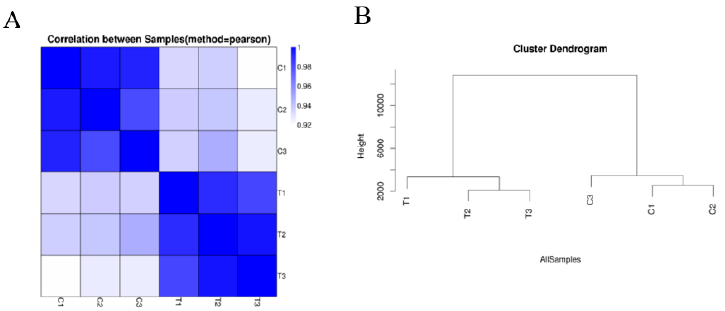
Figure 1. Sample quality test. ( A ) Heatmap of Pearson correlation between samples. The x- and y-axes represent each sample. ( B ) Hierarchical clustering between all and samples. C1, untreated hairy roots group number 1; C2, untreated hairy roots group number 2; C3, untreated hairy roots group number 3; T1, hairy roots treated with 200 µ M Cd for 1 d, group number 1; T2, hairy roots treated with 200 µ M Cd for 1 d, group number 2; T3, hairy roots treated with 200 µ M Cd for 1 d, group number 3.